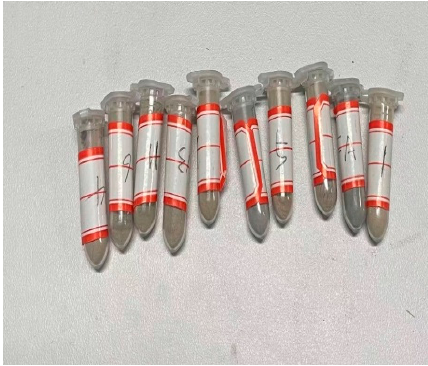
Figure 4. XRD test powder.